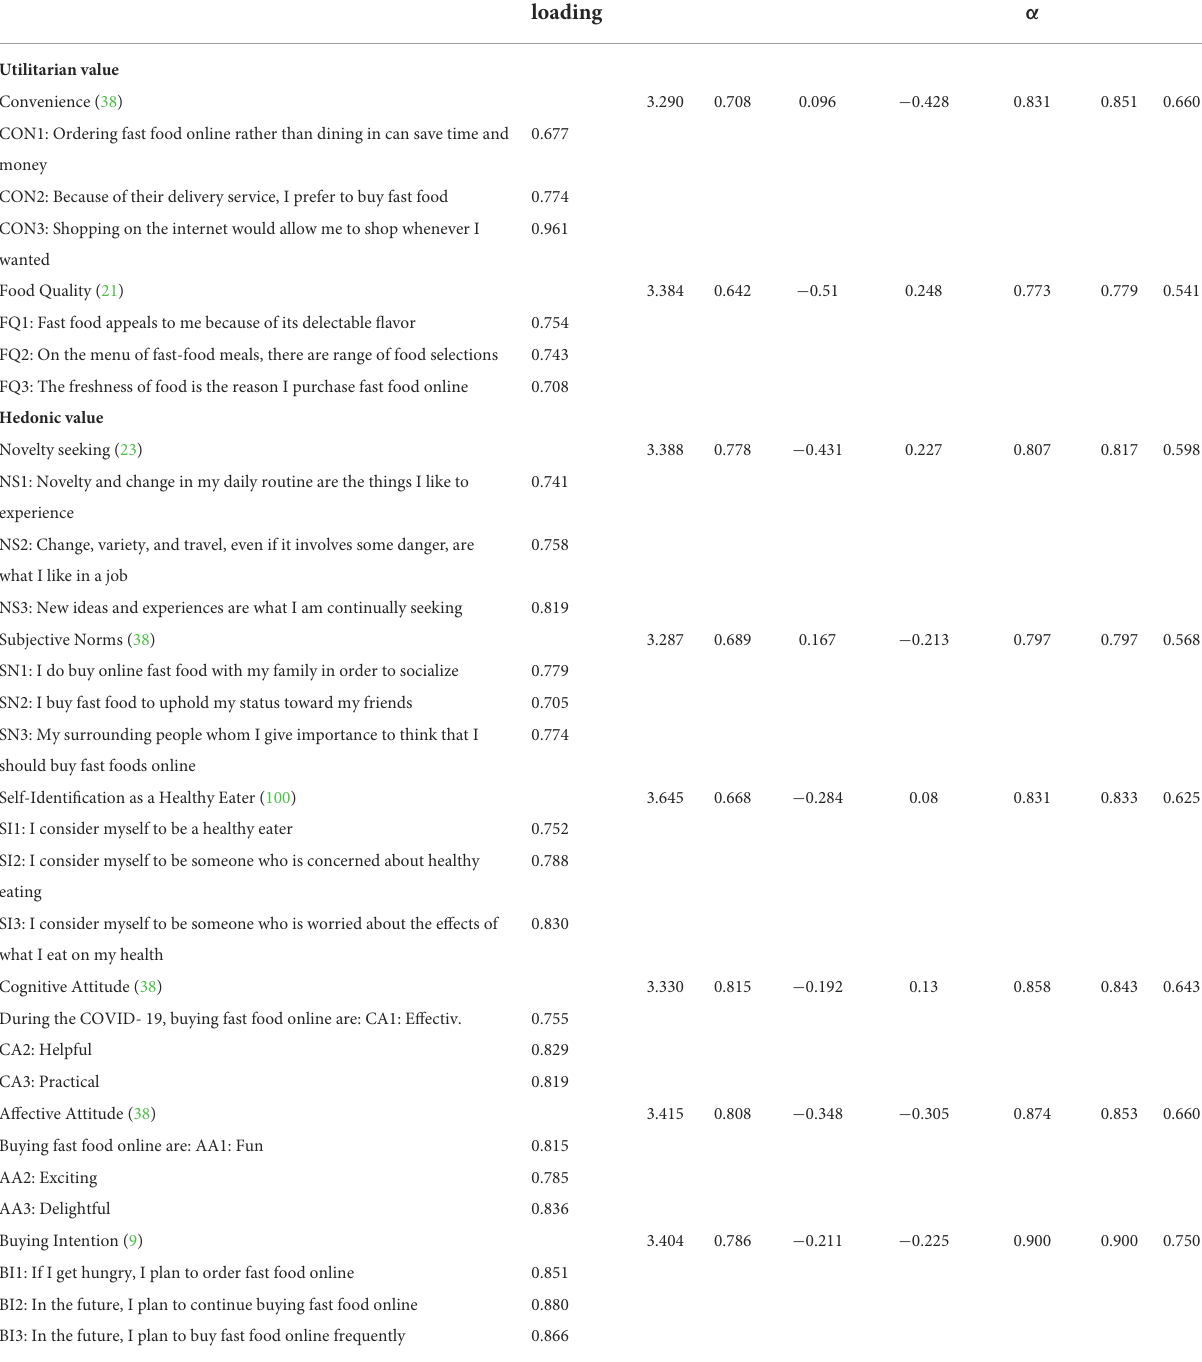
TABLE 1 Cronbach alpha, composite reliability,